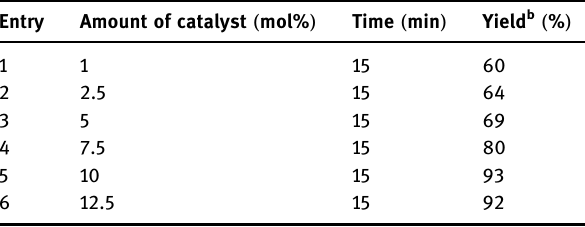
a Reaction of picolinaldehyde, diethyl ( 4 -( 2,4 - dichlorophenyl )